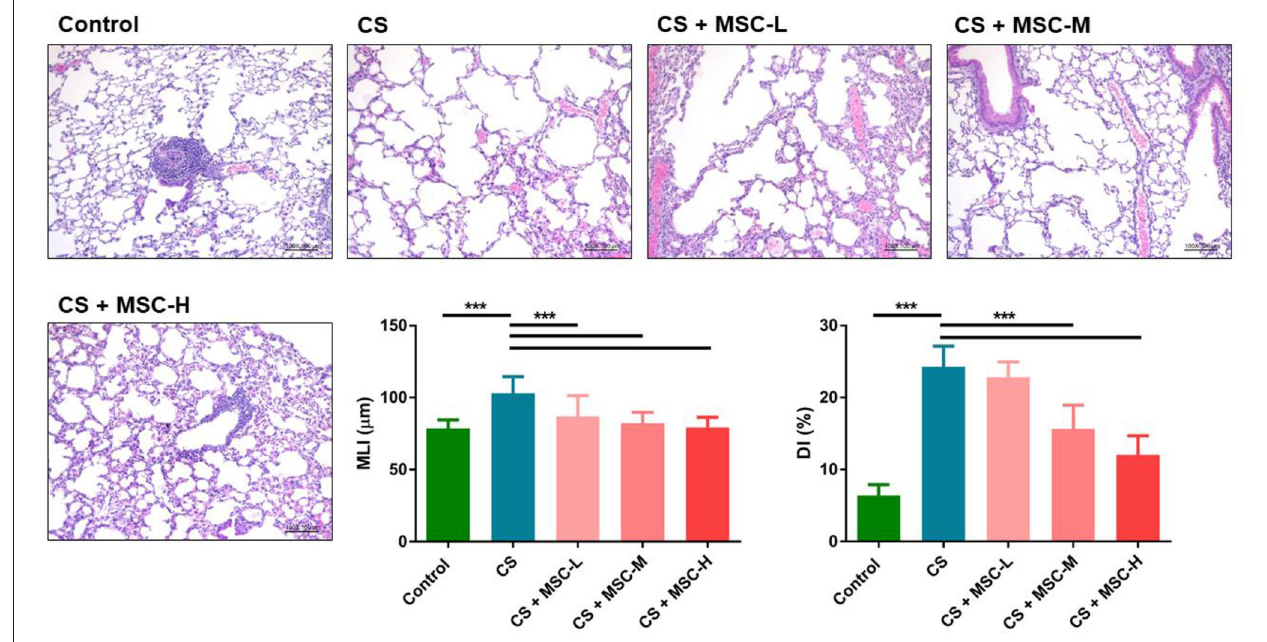
FIGURE 2 | Repair of alveolar structures by human umbilical cord-derived mesenchymal stem cells (hUC-MSCs) in a mice model of cigarette smoke (CS)-induced emphysema. Lung tissue sections were stained with hematoxylin and eosin (H&E). Lung lesions were quantified by measuring the mean linear intercept (MLI) and destructive index (DI). Significant reductions of the MLI and DI (%) were observed by hUC-MSC administration after CS exposure for 4 months. Results were determined by a one-way ANOVA with Tukey’s test. n = 8–10 per group. *** p < 0.001.